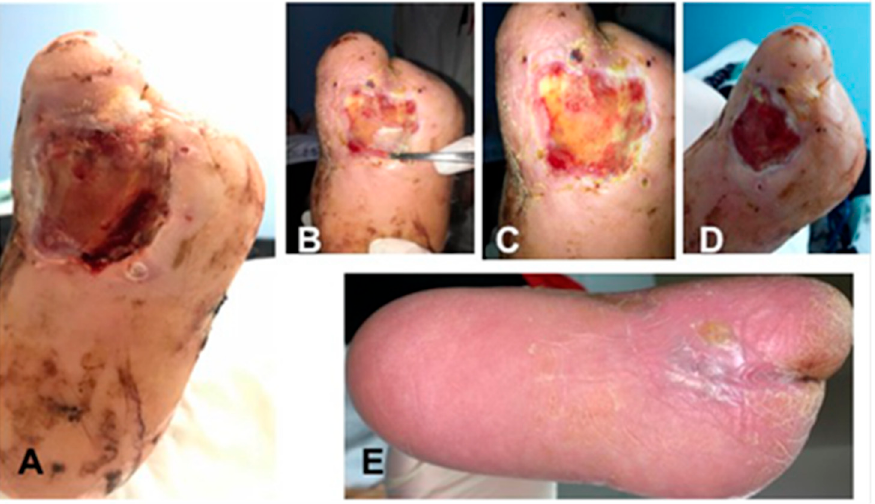
Figure 3. Lesion after treatment with IDRT at T 2 before removal of silicone layer ( A ), at T 3 after removal of silicone layer ( B , C ), at T 4 ( D , E ), and the complete wound healing ( F ).